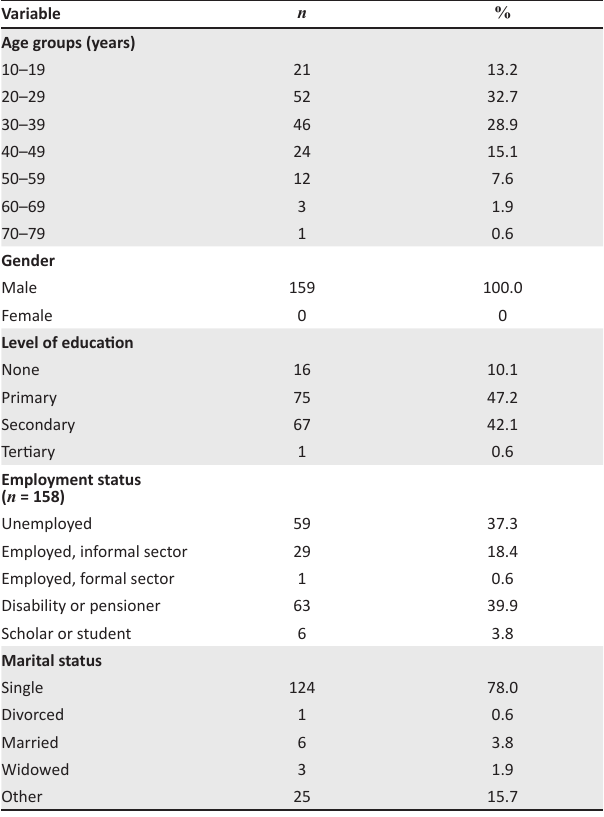
TABLE 1: Sociodemographic characteristics of offenders accused of rape ( n = 159).